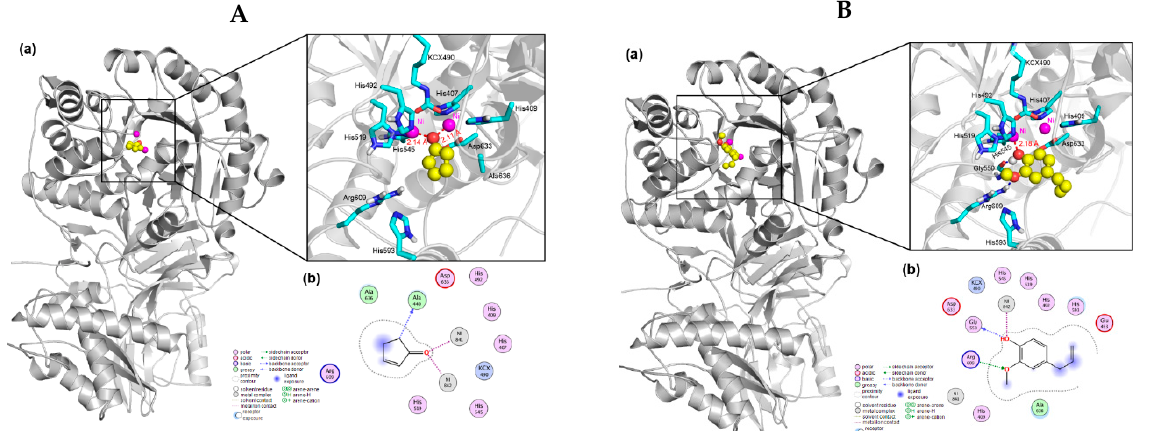
Figure 3. ( A ) Docking structure ( a ) and 2D representation of binding mode ( b ) of 2-Cyclopenten-1-one; ( B ) Docking structure ( a ) and 2D representation of binding mode ( b ) of Eugenol. Amino acids are highlighted in light blue, each inhibitor compound is highlighted in yellow. Hydrogen bonds are presented as light dotted lines.